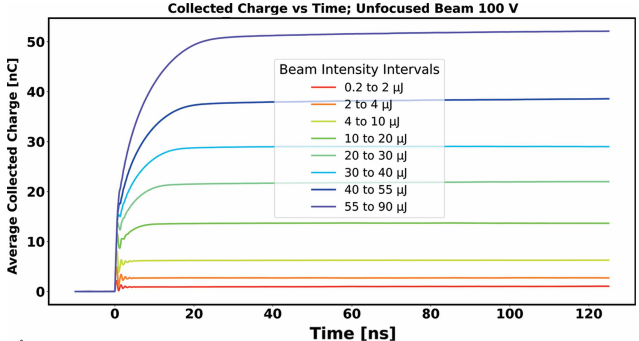
Figure 8 Collected charge as a function of collection time for a sensor bias of 100 V, with the beam focused to a FWHM of 350 m